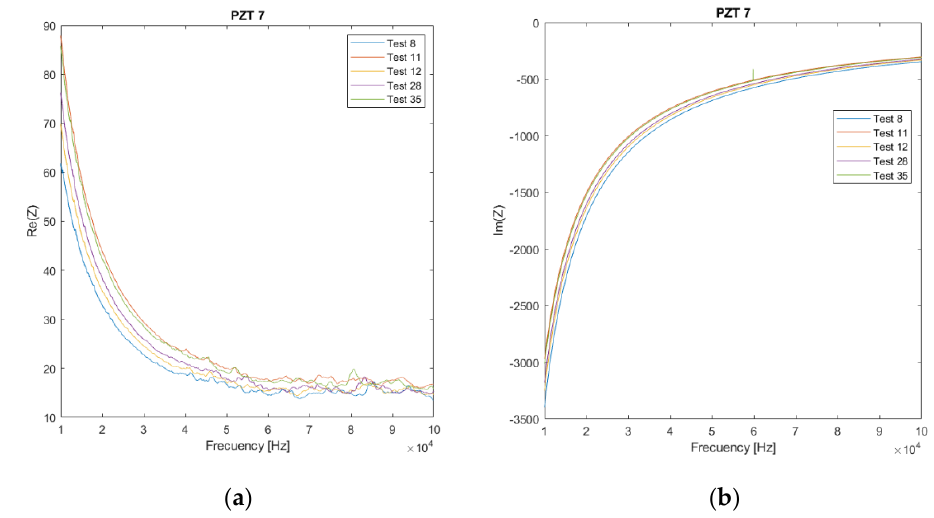
Figure 5. Impedance spectra for PZT7. ( a ) Real part; ( b ) Imaginary part.